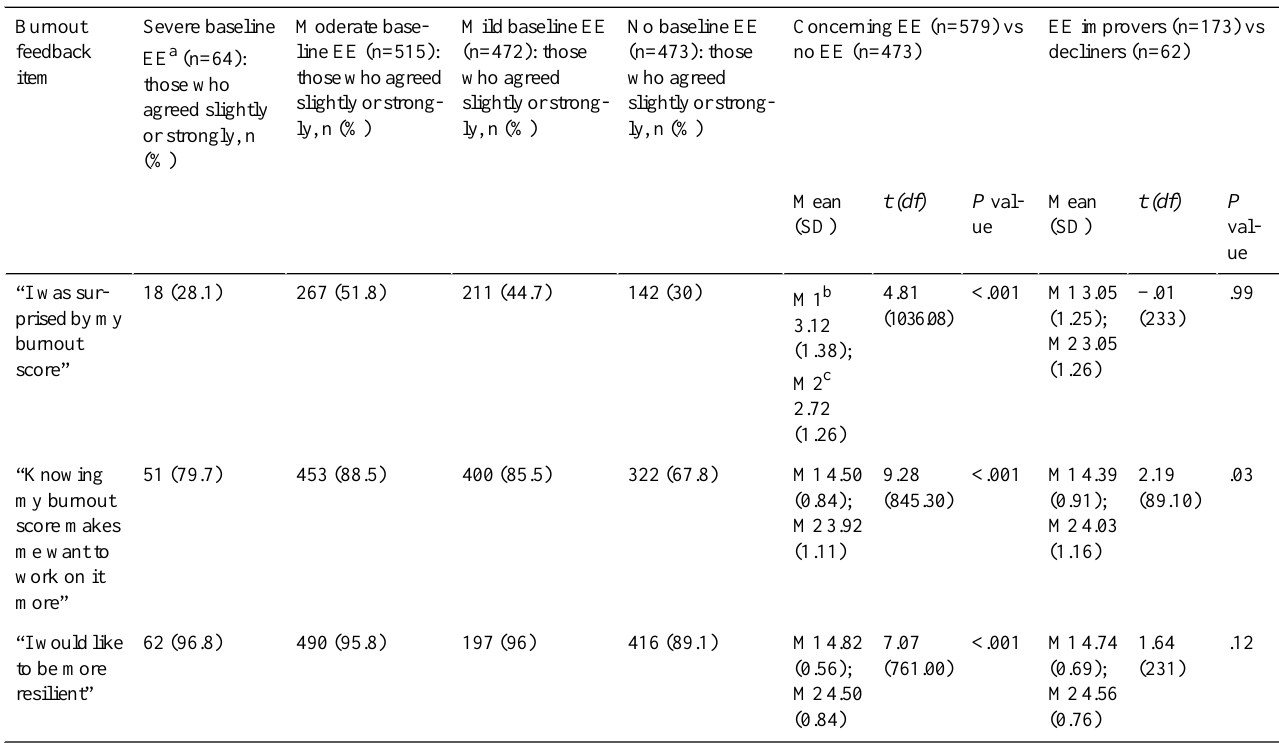
Table 5. Reactions to receiving burnout feedback, differences by baseline emotional exhaustion levels, and emotional exhaustion improvers vs decliners. Responses were on a 1 (disagree strongly) to 5 (agree strongly)